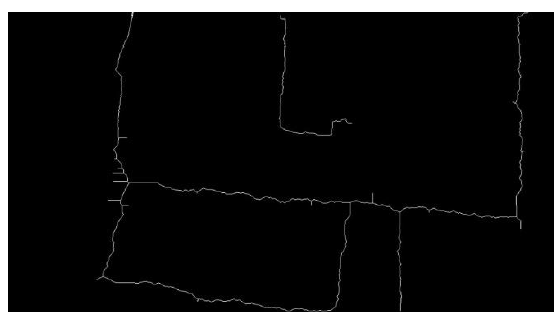
Figure 4. 4(a) Final road centerline by iteration technique; 4(b) Final road centerline by singly thinning and spur operators.